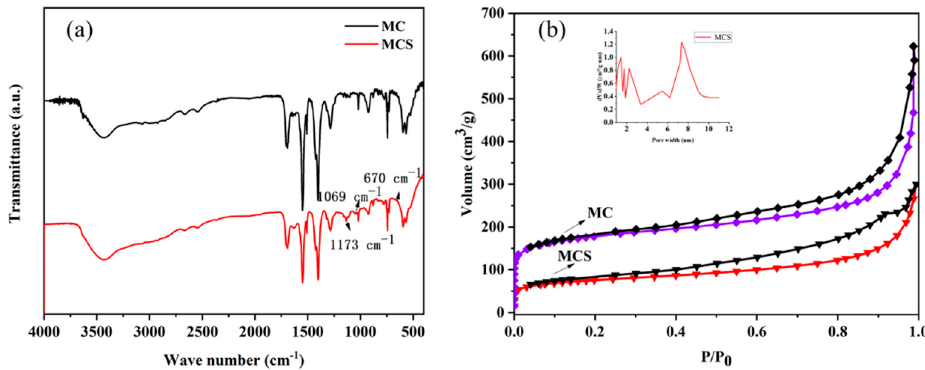
Figure 6. FT-IR spectra ( a ) and N 2 adsorption-desorption isotherms ( b ) of pristine and modified MIL-101(Cr).